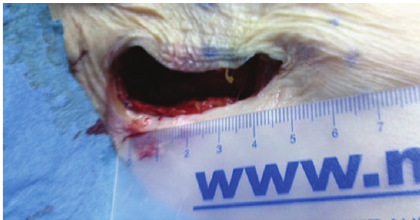
Figure 2: The picture showing the incision.